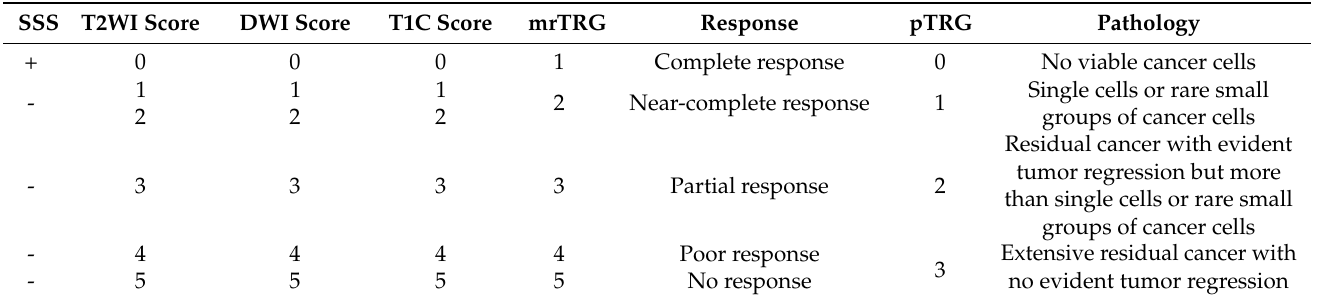
Table 3. Modified MRI tumor regression grade and pathologic tumor regression grade with modified Ryan